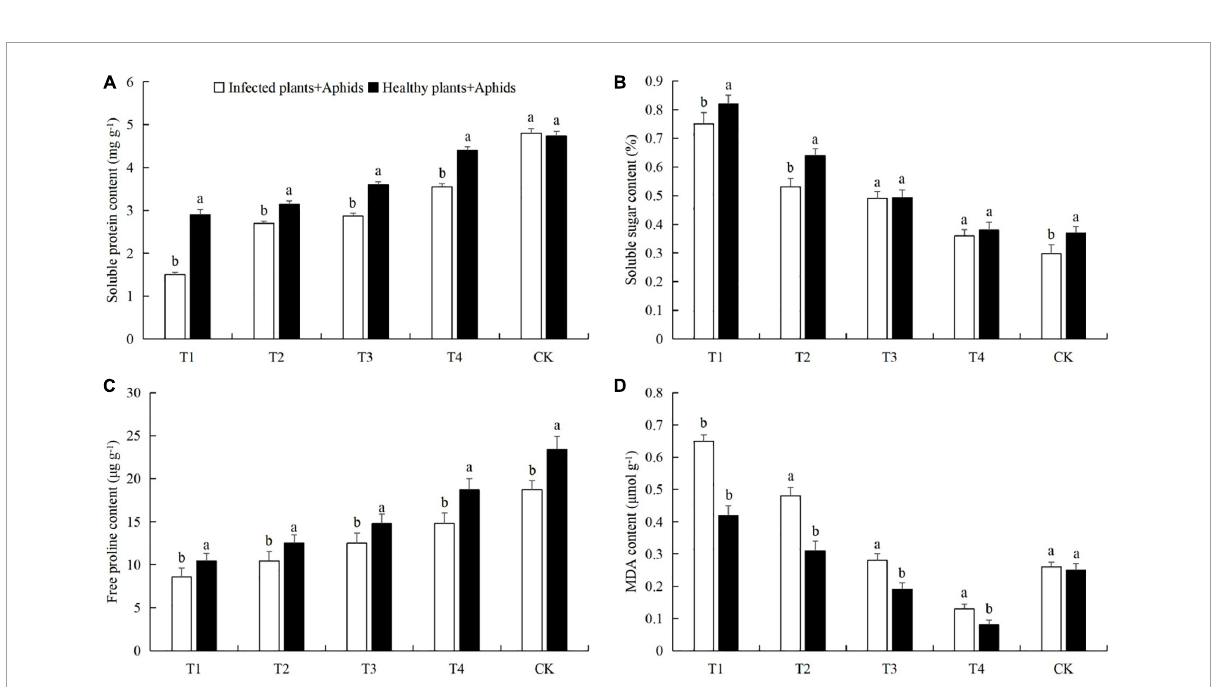
FIGURE6 Effects of different aphid densities on the contents of (A) soluble proteins, (B) soluble sugars, (C) free proline, and (D) malondialdehyde (MDA) in cucumber leaves after powdery mildew infection. T1, 160 aphids; T2, 80 aphids; T3, 40 aphids; T4, 20 aphids; CK, 0 aphids. The mean value ± p < 0.05 error bar data were presented in the figure and different alphabetical letters indicate the significant differences between the infected plants + aphids and the healthy plants +